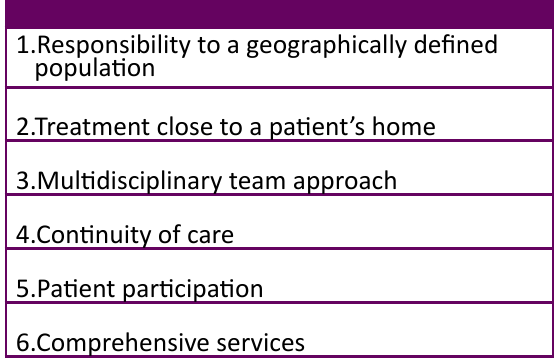
Table 1- Principles of community psychiatry -